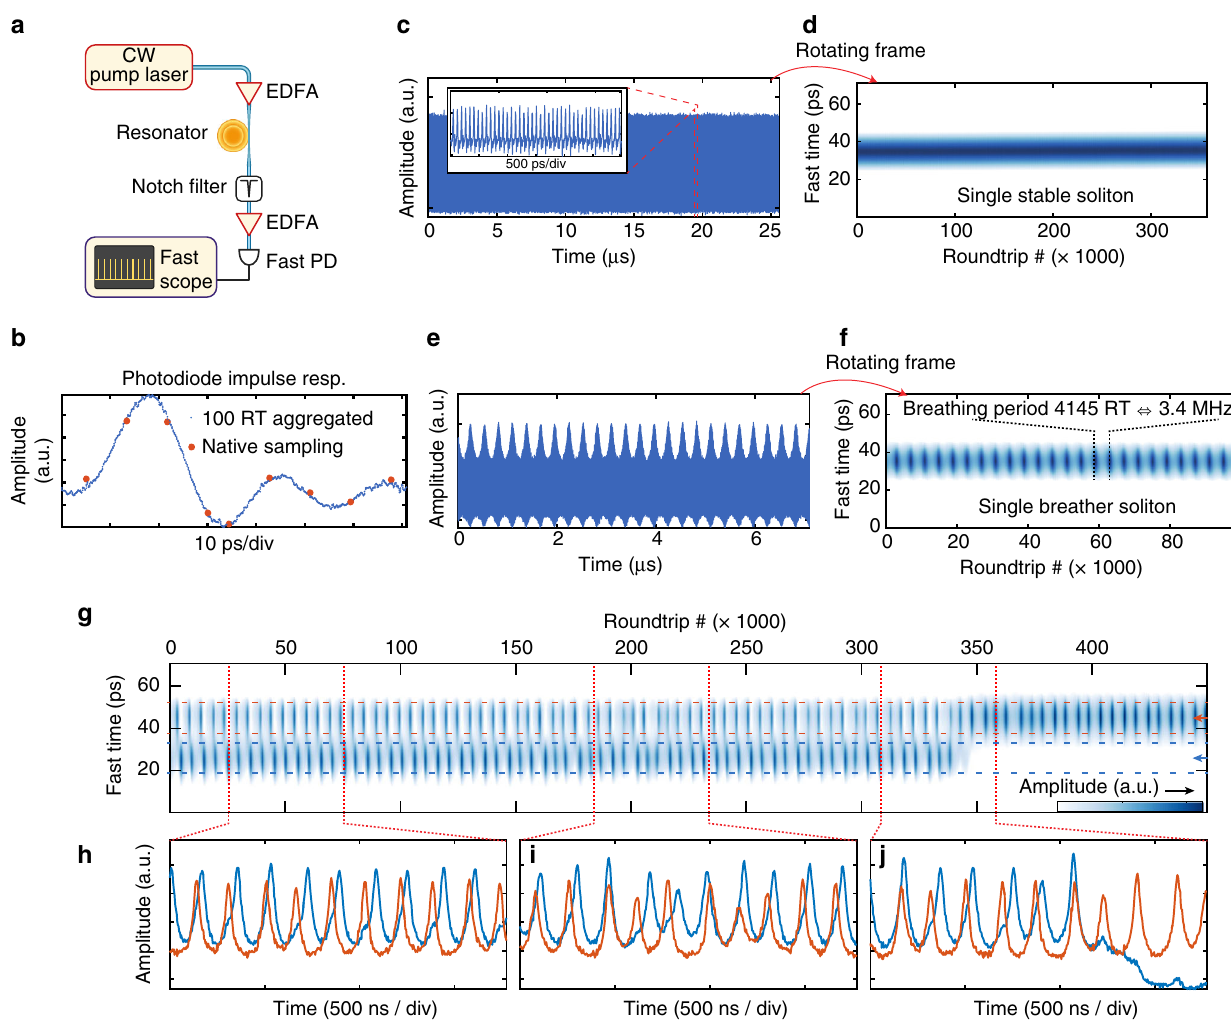
Fig. 5 Direct observation of the spatiotemporal dynamics. a Experimental set-up. EDFA, erbium-doped fi bre ampli fi er; PD, photodiode. b Photodiode response. The red dots mark the original sampling over a single roundtrip period (RT). With 9 points per period, the pulse amplitude cannot be accurately resolved. This problem is solved by aggregating 100 roundtrips to increase the effective sampling rate and retrieve the impulse response to a single soliton. c Single soliton pulse train, containing 3.5 × 10 5 roundtrips. The inset shows a short section of the trace, where individual pulses can be coarsely located. d Dividing the trace into groups of 100 aggregated roundtrips, and stacking reveals the spatiotemporal evolution of the soliton. The soliton position and amplitude is fi xed as the soliton is stable. In this map, the colourmap is set to remove the ripples of the photodiode response. e Single breathing soliton pulse train. f Applying the same procedure as in d reveals the oscillating pulse amplitude while its position remains stable. g Spatiotemporal evolution of a breathing two-soliton state undergoing a transition to a breathing single-soliton state (switching). h − j show the evolution of the amplitude of each soliton. h Traces showing a π /2 phase difference between the breathing oscillations of the solitons. i Unstable breathing, after which the quadrature relation is restored. j Collapse of one soliton, while the other survives and remains in the breathing